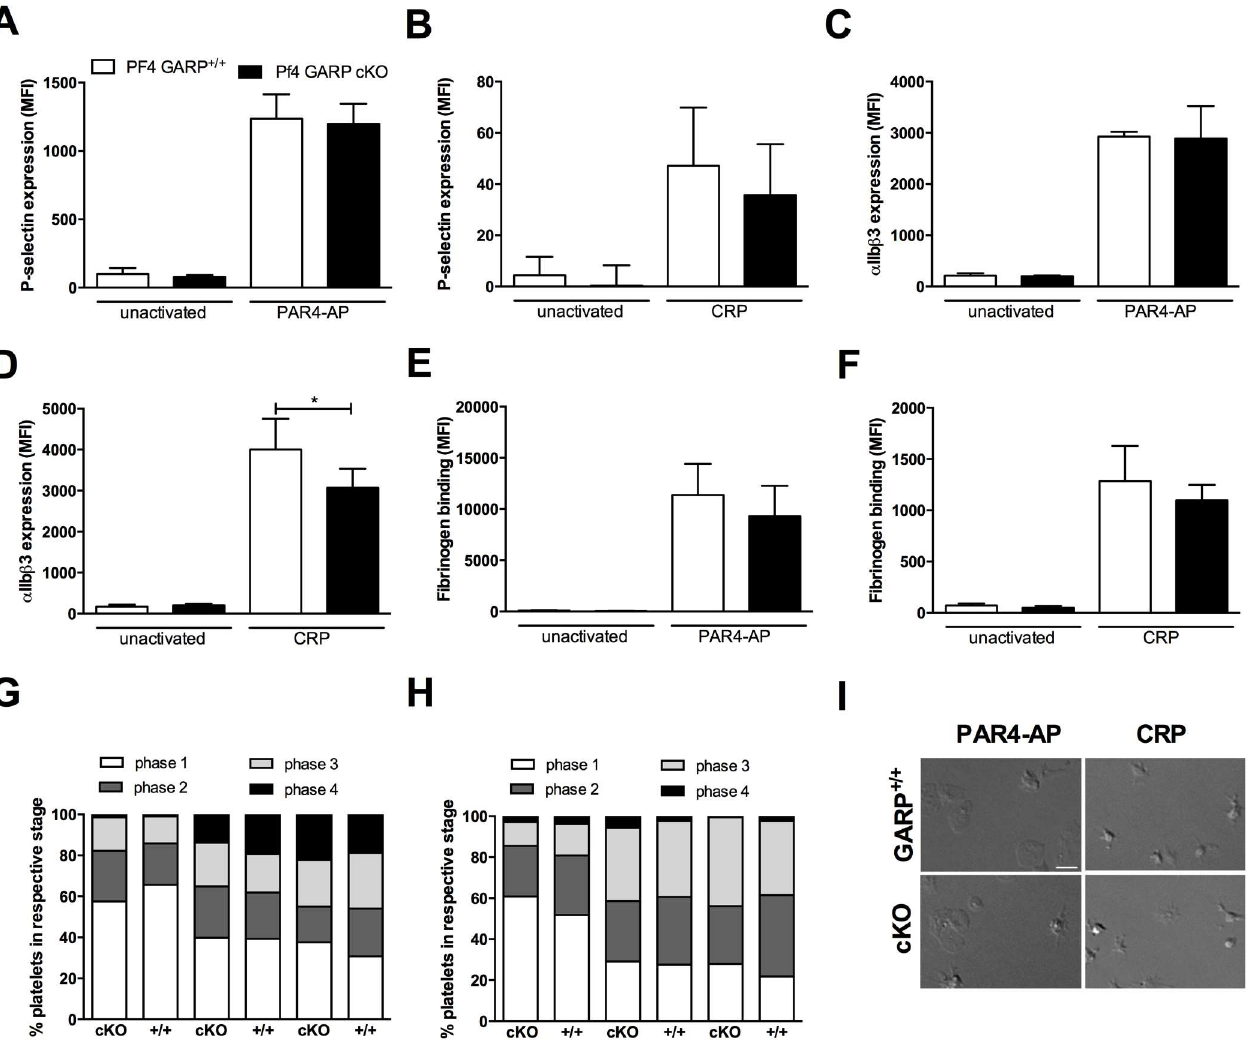
Fig 2. GARP expressionis elevated upon platelet activation but does not affect outside-in and inside-out signaling. MFI of P-selectin (anti-CD62P-PE) ( A-B ), JON/A (anti-GPIIbIIIa-PE) ( C-D ) and fibrinogenbinding( E-F ) to unactivatedor 200 μ M PAR4-AP ( A-C-E ) or 2.5 μ g/mL CRP ( B-D-F ) activated platelets of littermates and cKO mice are measuredusing flowcytometry. Platelets were gated basedon CD41 (anti- CD41-FITC) expression. Graphs show mean ± SD, n = 3. Washed plateletsof littermates and cKO mice were allowedto spread on 100 μ g/mL fibrinogenwhileactivated with 200 μ M PAR4-AP ( G ) or 2.5 μ g/mL CRP ( H ) during5, 10 or 30 min. Platelets are dividedin different phases of activation(1) round, (2) only filopodia,(3) filopodiaand lamellipodia, (4) fully spread. ( I ) Representative images of platelet spreading;scale bars represent 5 μ